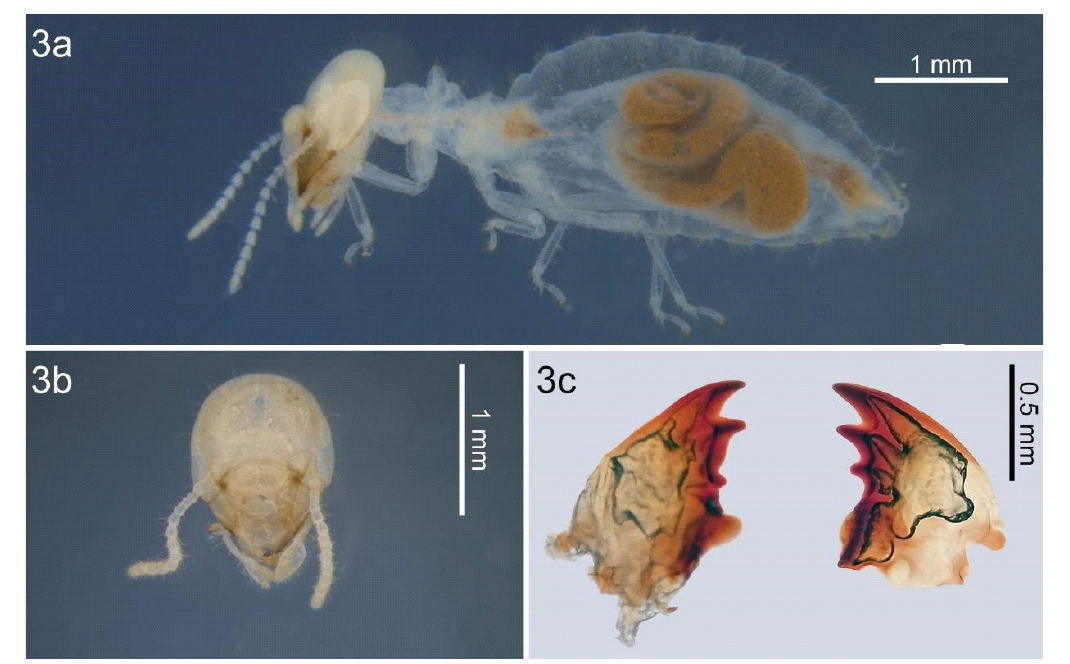
Fig 3 . Pericapritermes ceylonicus (Holmgren) worker; a) Lateral view of body; b) Dorsal view of head; c) Left and right mandible. Worker gut morphology (Figs 4,